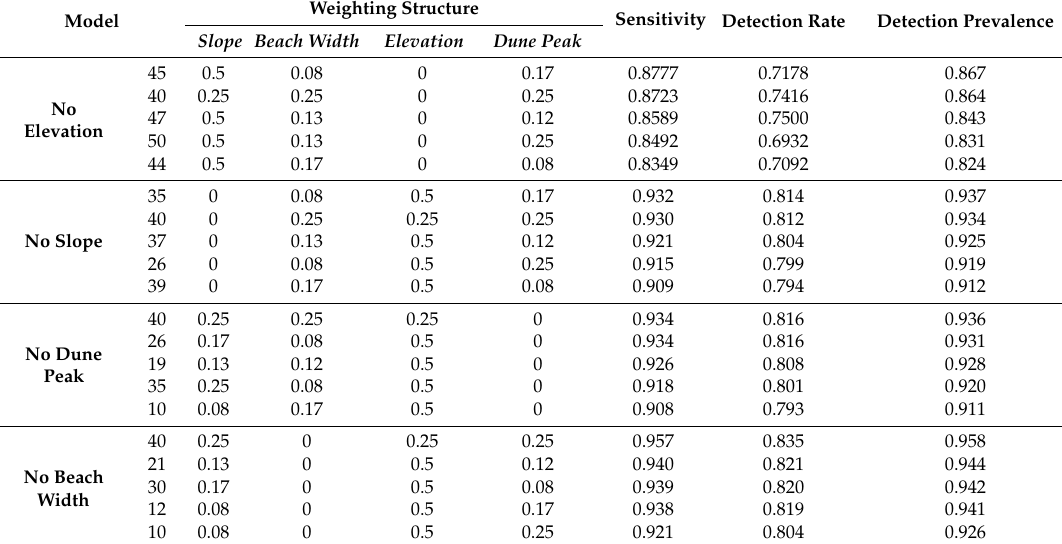
Table 3. Top resulting models from model sensitivity analysis in which one parameter was removed from all 57 weighting